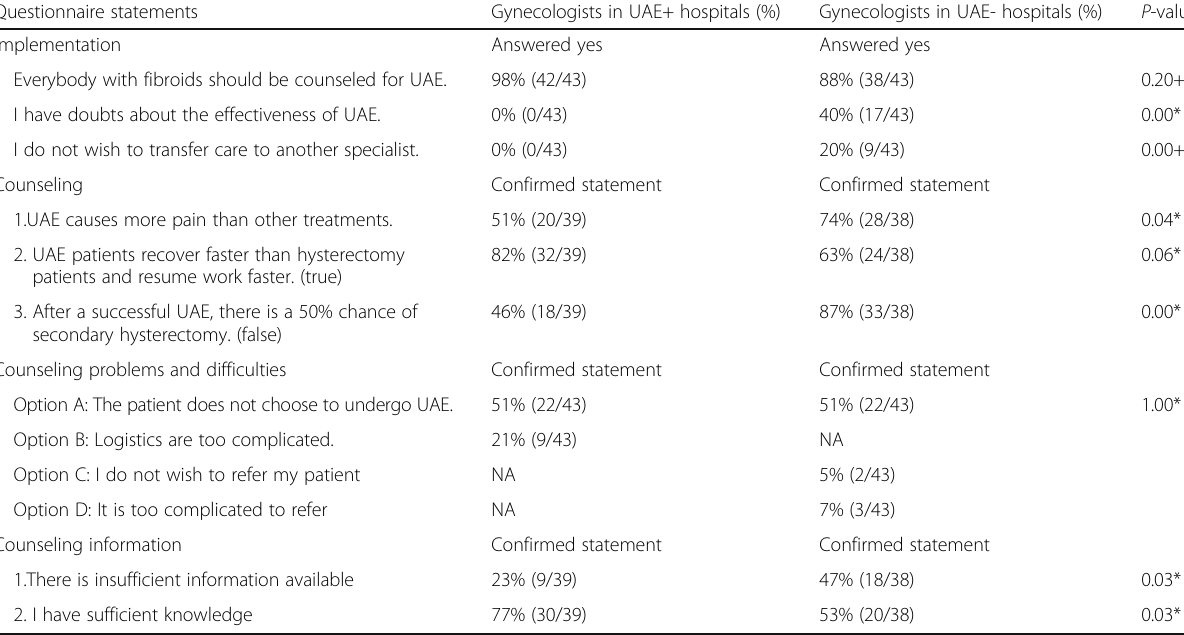
Table 3 Questions asked in the survey for both gynecologists working at UAE+ and UAE- hospitals Questionnaire